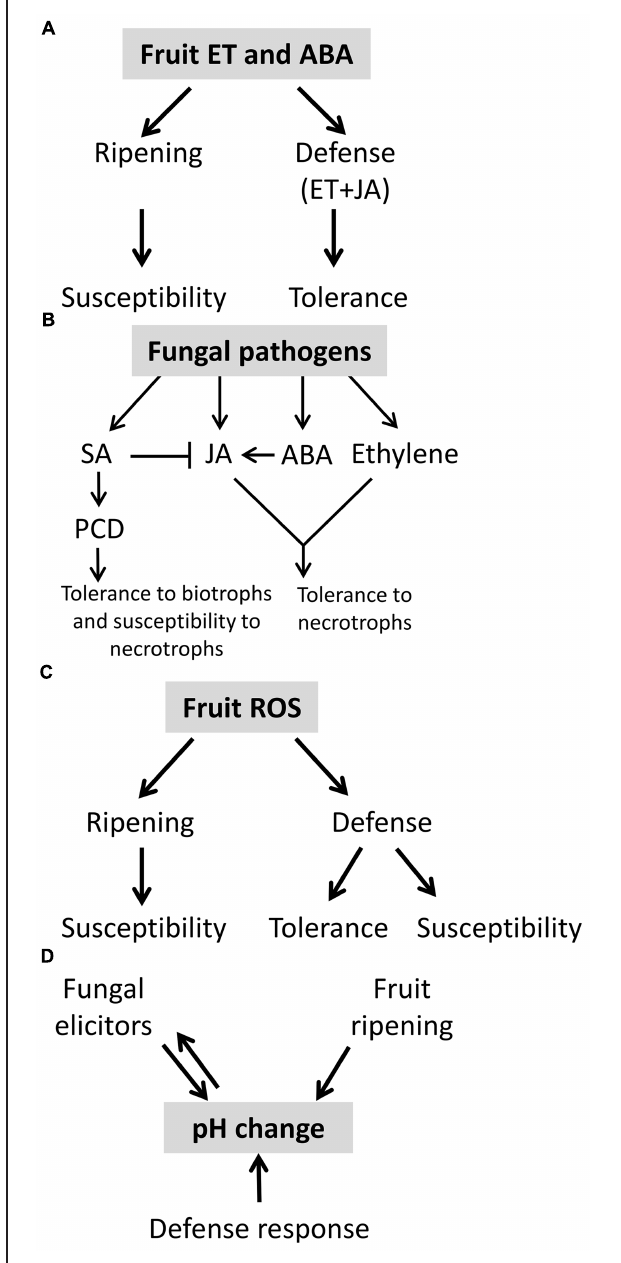
FIGURE 4 | Role of phytohormones, ROS, and pH in post-harvest disease. (A) Ethylene and abscisic acid (ABA) activate fruit ripening and susceptibility in fruit but also participate in the defense response to pathogens together with JA. This interplay of hormonal signals can lead to increased tolerance. (B) Fruit defense response to fungal pathogens is mediated by phytohormones as salicylic acid (SA), jasmonic acid (JA), ABA, and